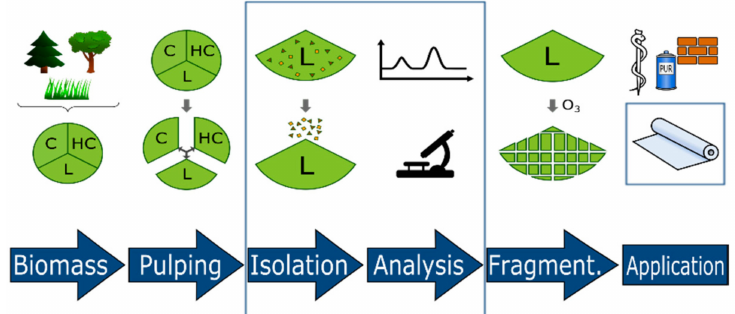
Figure 1. Development of lignin-derived materials starting with biomass pulping, lignin isolation and structure elucidation, guided fragmentation (e.g., ozonolysis), and application in construction, packaging, and biomedicine (C: cellulose, HC: hemicellulose, L: lignin).